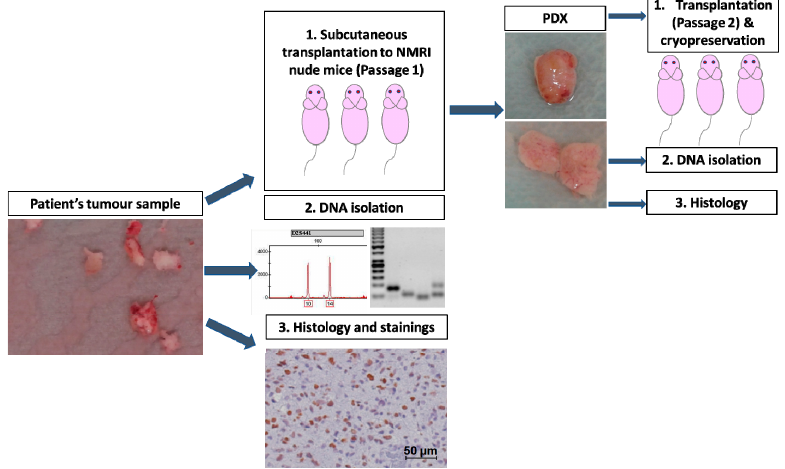
Figure 1. Experimental design for the establishment. Patients’ samples were obtained from the